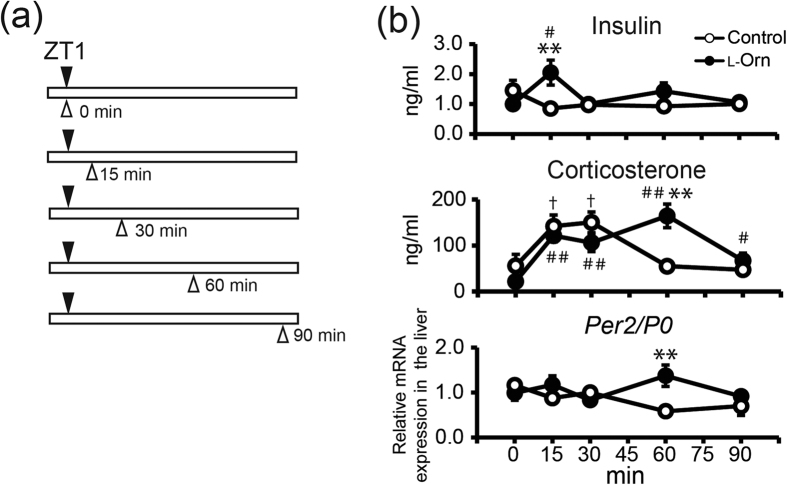
Time course of insulin, corticosterone, and mPer2 mRNA expression induced by L-ornithine administration in the non-fasted condition.(a) Experimental schedule. Mice were entrained to the light-dark cycle for at least 14 days. At ZT 1, l-ornithine (1,000 mg/kg) or vehicle was administered to mice (filled arrowhead), and plasma and tissue samples were collected after 0, 15, 30, 60, and 90 min (open arrowhead). (b) Time course of insulin and corticosterone in plasma, and mPer2 mRNA (normalized to P0) in the liver (mean ± SEM, n = 9–10 mice respectively). **P < 0.01, *P < 0.05 versus control (Mann-Whitney U test), ##P < 0.01, #P < 0.05 versus 0-min value (l-ornithine-treated group, Steel test), †P < 0.05 versus 0-min value (control group, Steel test).